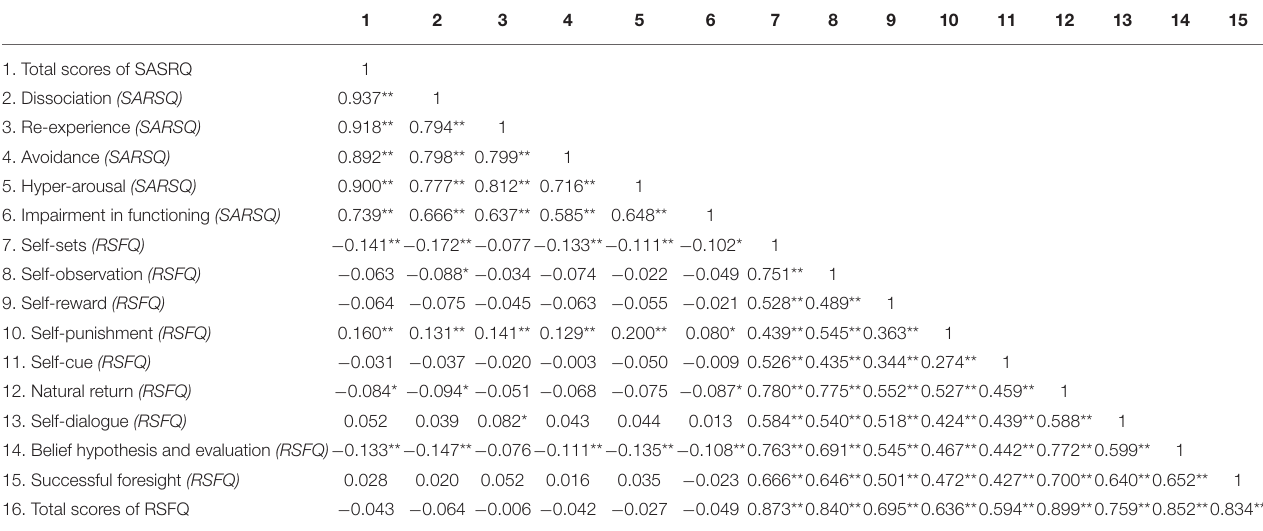
TABLE 2 | Pearson’s coefficient correlations between the ASR and self-leadership in